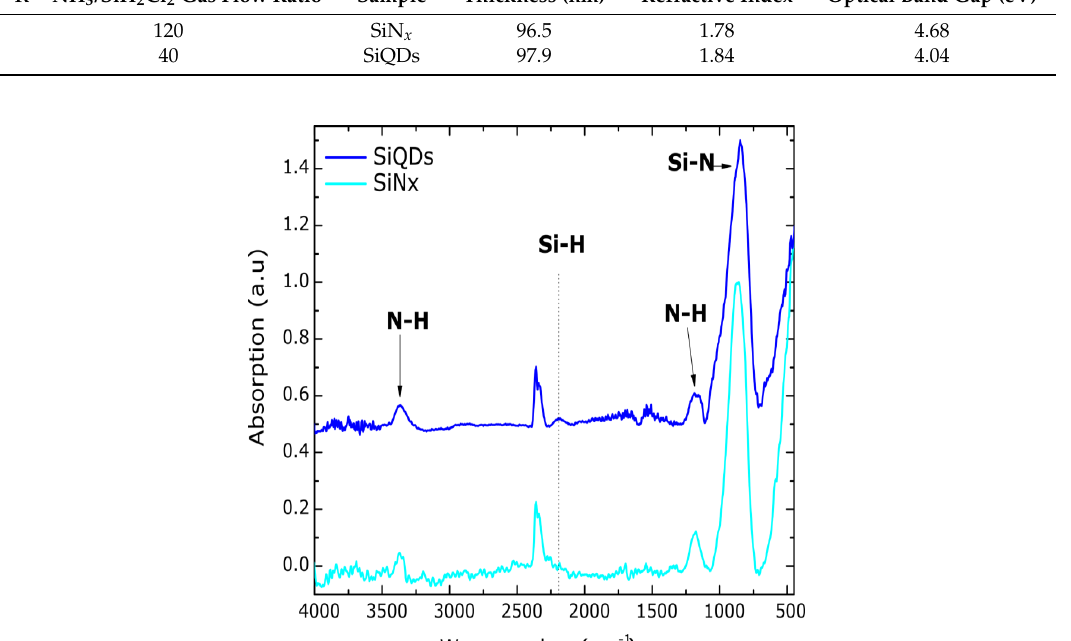
Table 1. Some physical properties of the silicon nitride layers with different chemical composition. R = NH 3 /SiH 2 Cl 2 Gas Flow Ratio Sample Thickness (nm) Refractive Index